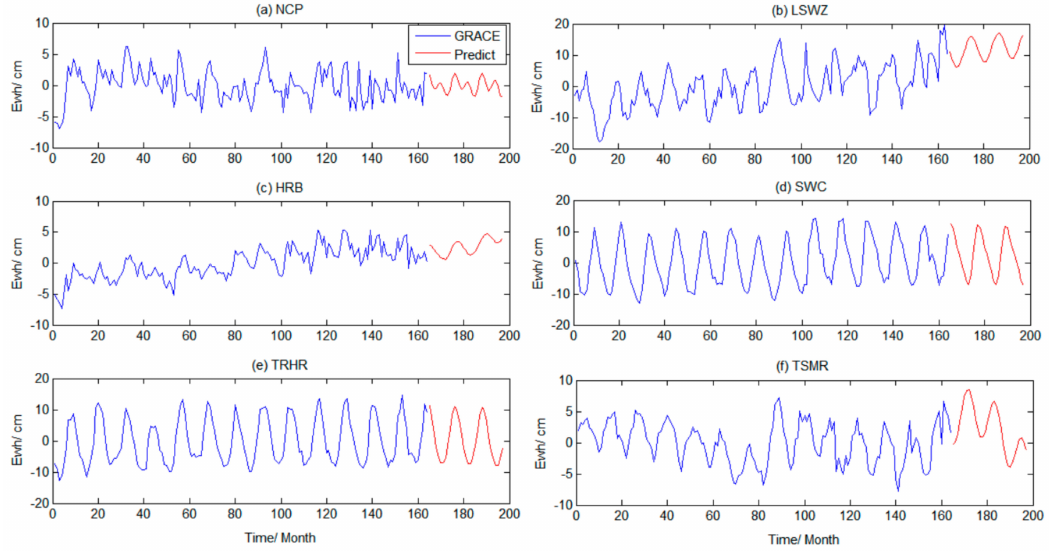
Figure 7. Time series of GRACE inversion results and SSA prediction